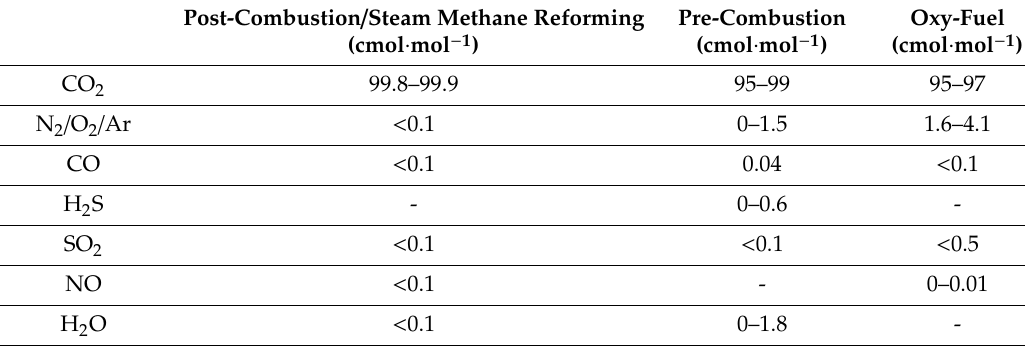
Table 1. Carbon dioxide compositions for typical processes (including purification step where applicable) according to the literature [10–12].